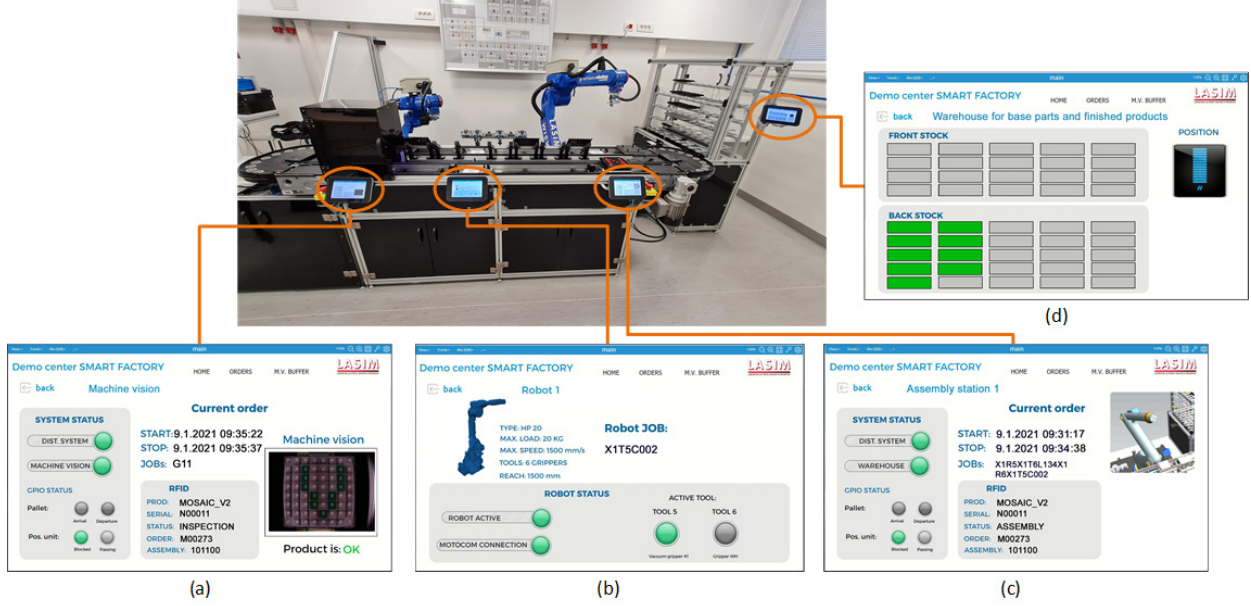
Figure 18. Visualization of the processes for the case study for different building blocks in the fourth scenario: ( a ) Machine vision, ( b ) Robot 1, ( c ) Assembly station 1, and ( d ) WBPFP.